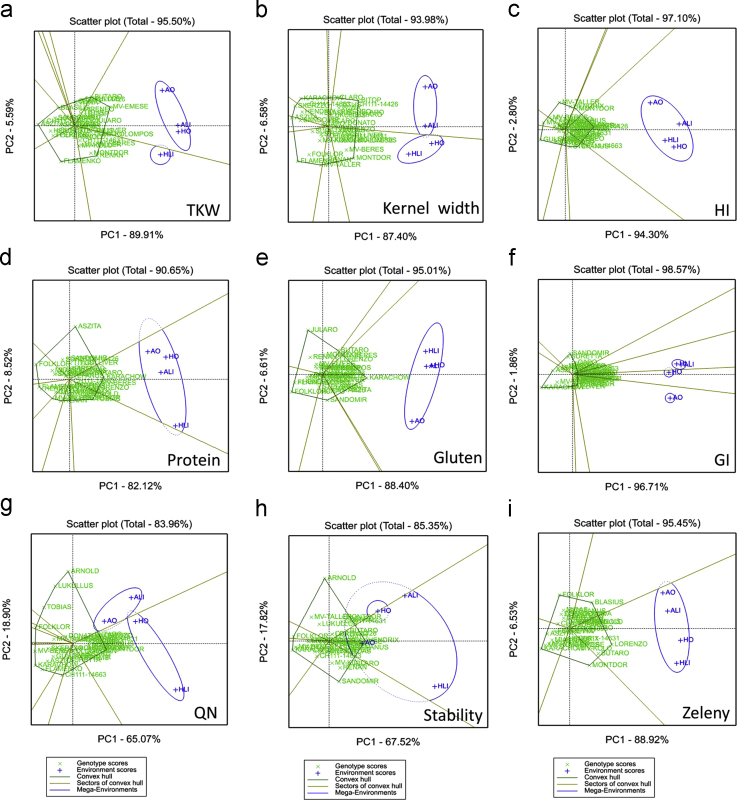
The ‘which-won-where’ view of the GGE biplot to show which genotype performed best in which environments ((a) thousand kernel weight: TKW; (b) kernel width; (c) hardness index: HI; (d) protein content; (e) gluten content; (f) gluten index: GI; (g) Farinograph quality number: QN; (h) dough stability: stability; and (i) Zeleny sedimentation).